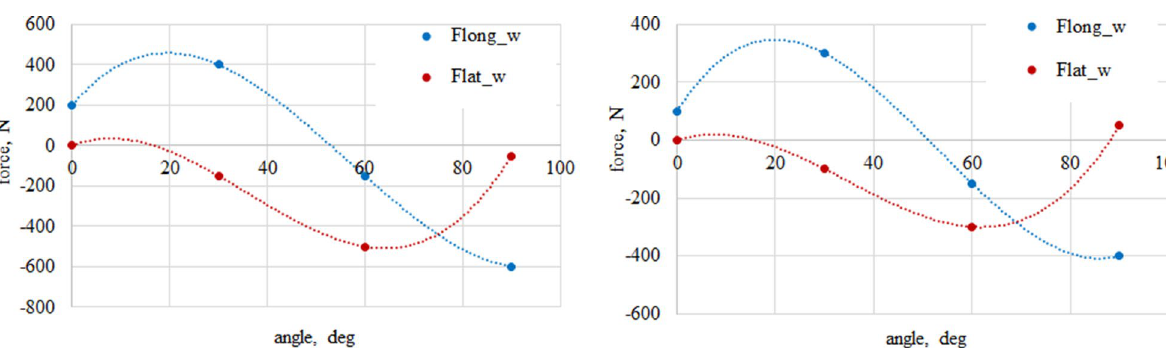
Figure 13. Values of longitudinal and lateral forces depending of the slip (attack) angle—loose snow.